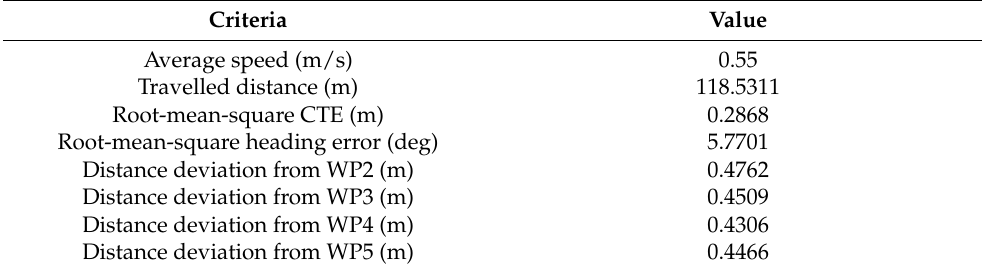
Table 7. Quantitative evalution in control and guidance performance of USV2000.